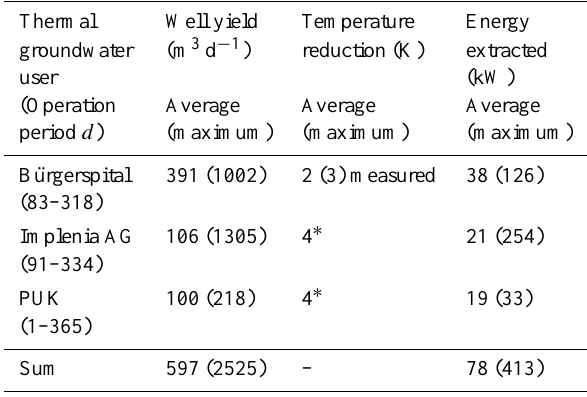
Table 2. Energy extracted for cooling by thermal groundwater users for 2010 (see Fig. 1 for locations of thermal